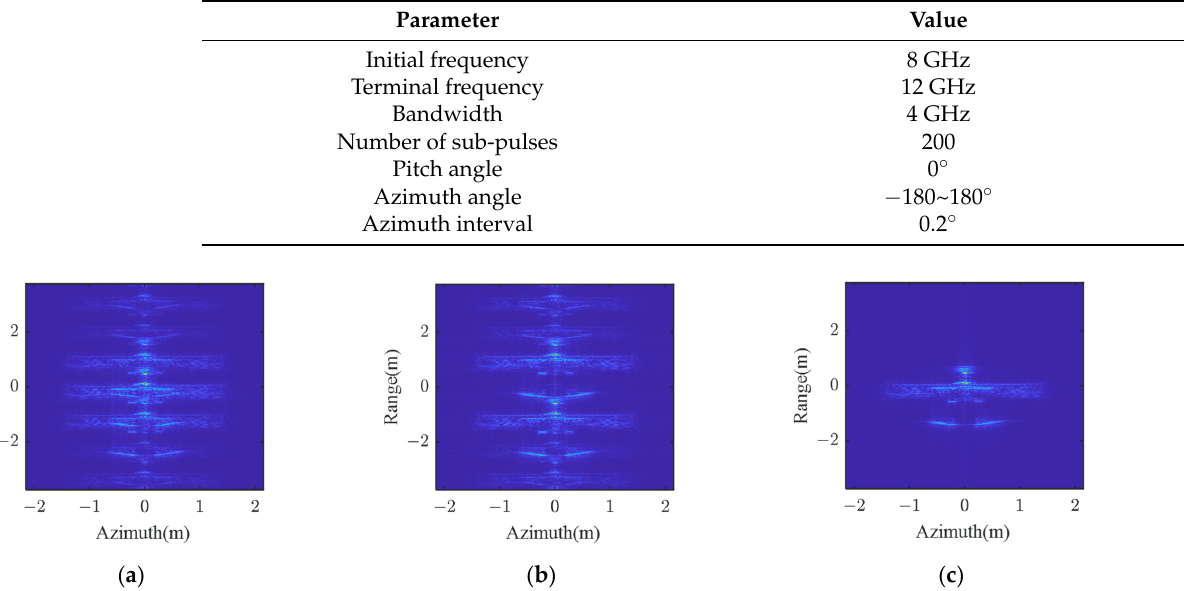
Table 2. Signal parameters.